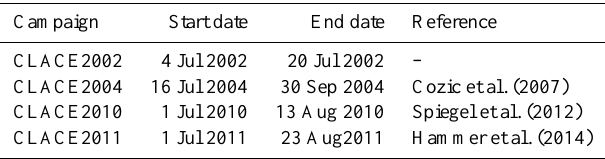
Table 1. Dates and references for each CLACE